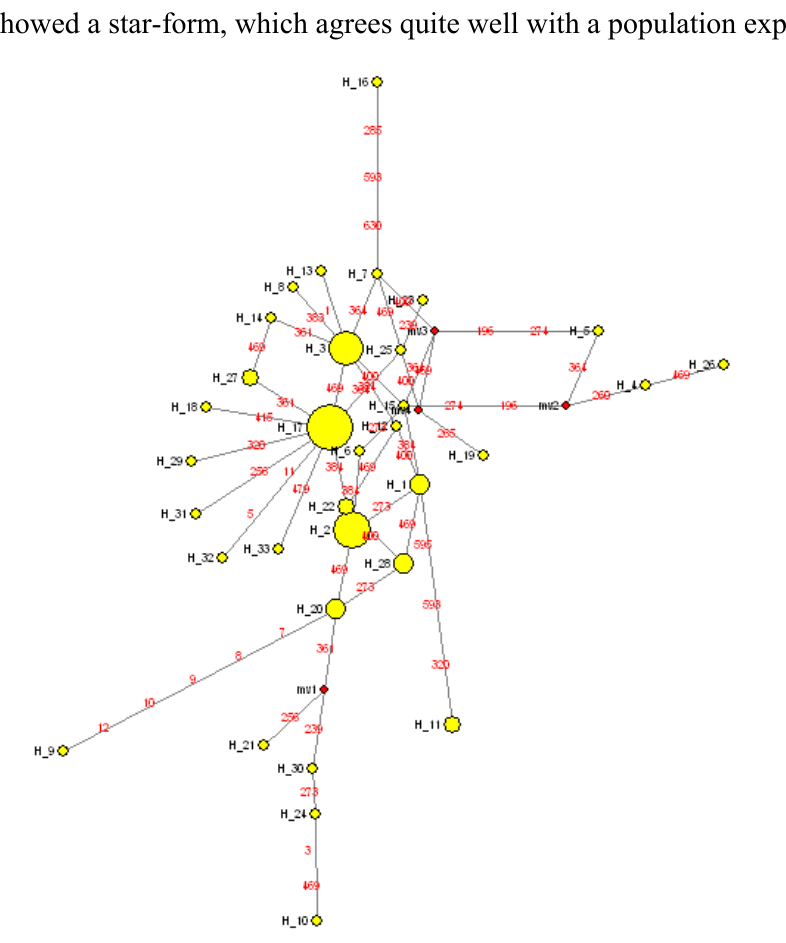
Figure 4. Median Joining Network (MJN) for the mitochondrial haplotypes found at the control region gene for the Sotalia guianensis population at the Amazon River’s